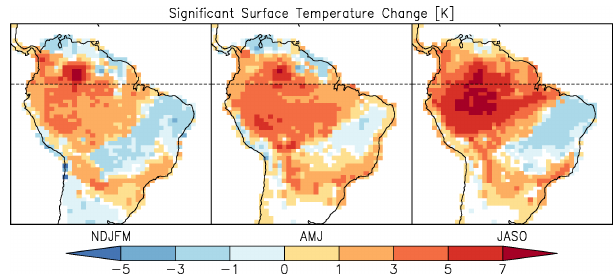
Figure 4. Change in surface temperature (K) for NDJFM, AMJ and JASO. Shading indicates significance at the 95% confidence